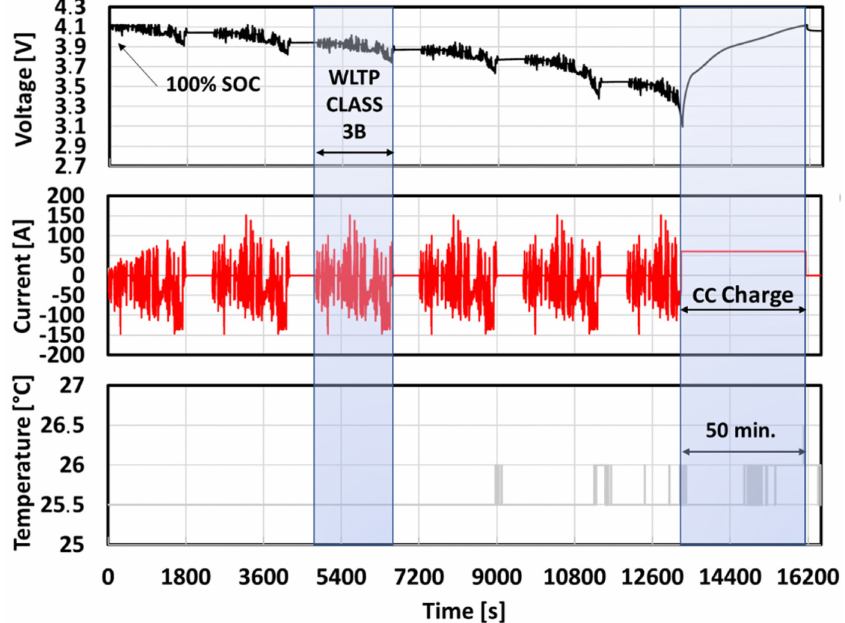
Figure 8. Voltage current and temperature profiles recorder during a single step of ageing test of driving cycle ageing at 25 ◦ C.